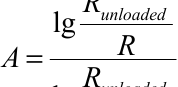
Figure 6. Setup for the combined wirebound and microwave-based approach to determine the average and spatially resolved NO